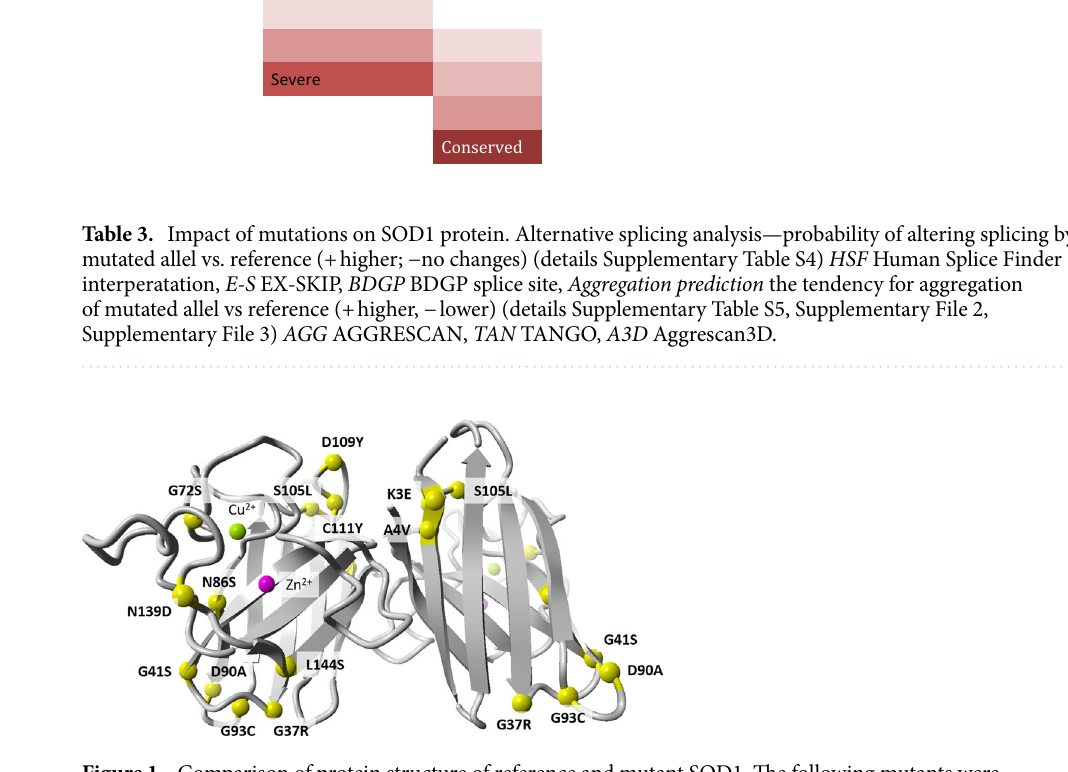
Figure 1. Comparison of protein structure of reference and mutant SOD1. The following mutants were modelled basing on the reference structure (PDB id:2C9V): K3E, A4V, G41S, N86S, D90A, G93C, S105L, D109Y, C111Y, L126*, N139D, and L144S.